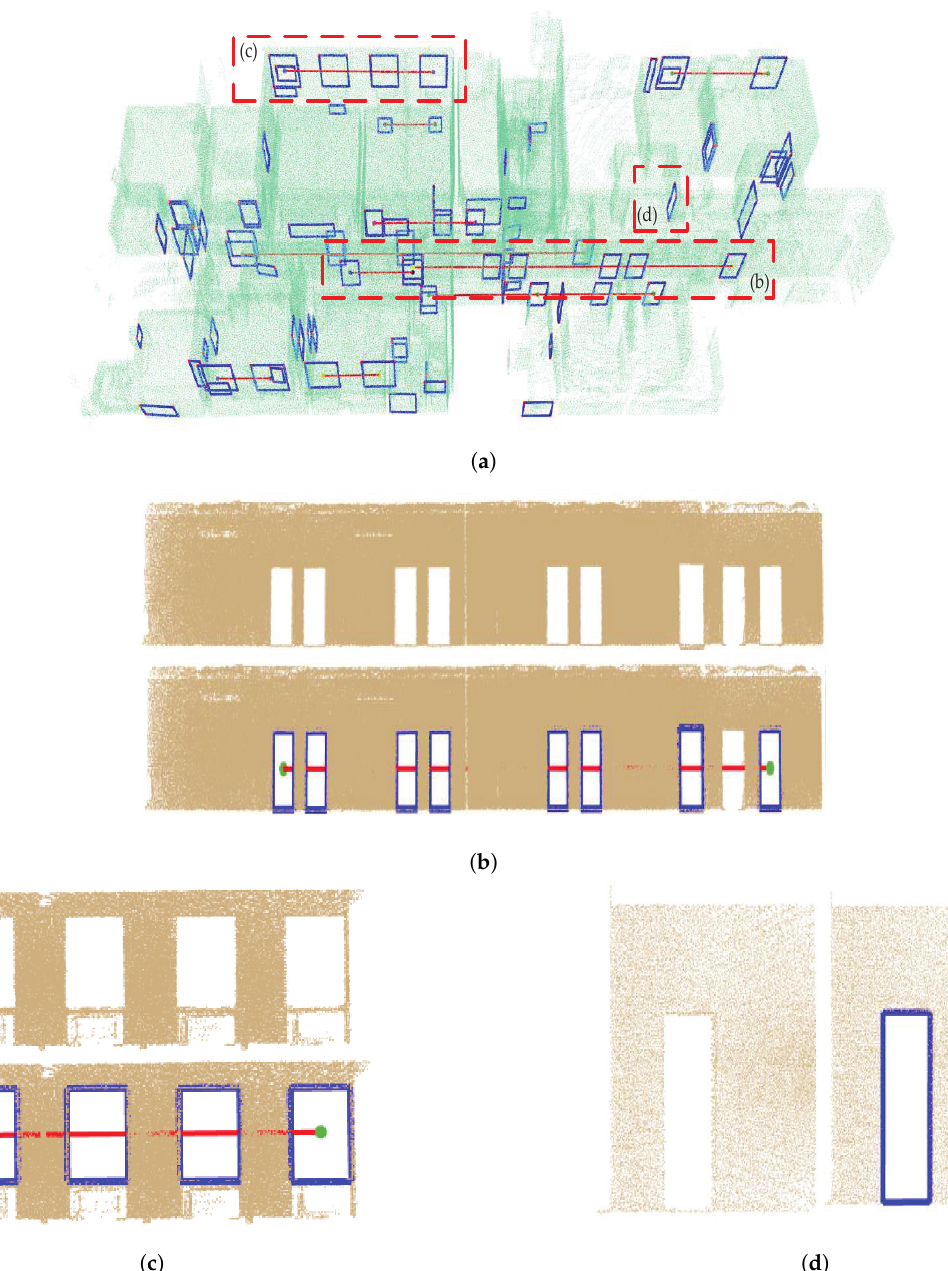
Figure 11. Wall opening detection and reconstruction on the ISPRS indoor dataset TUB2. The blue frames are the reconstructed openings and the red lines represent the association of openings. ( a ) A combination of the subsampled point cloud and the reconstructed openings. The red dot frames indicate the selected sections for detailed demonstrations; ( b ) A wall in a corridor; ( c ) A section of windows. The upper figures of ( b , c ) show the raw point cloud of the sections. The lower figures demonstrate the reconstructed openings and their associations; ( d ) A wall with one door. The left figure shows the raw data and the opening model is on the